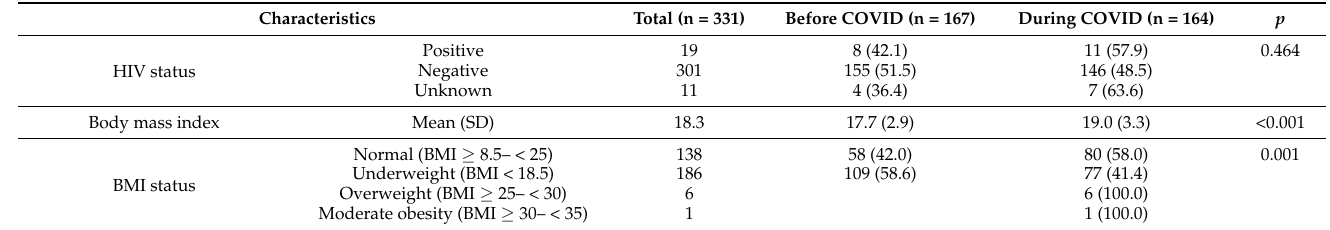
Table 2. Clinical comorbidities and characteristics of recruited TB patients during the ‘before’ and ‘during’ COVID